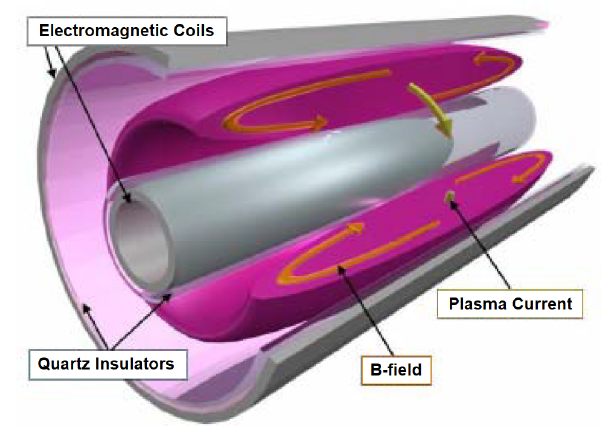
Figure 12. Diagram of an AFRC thruster (from